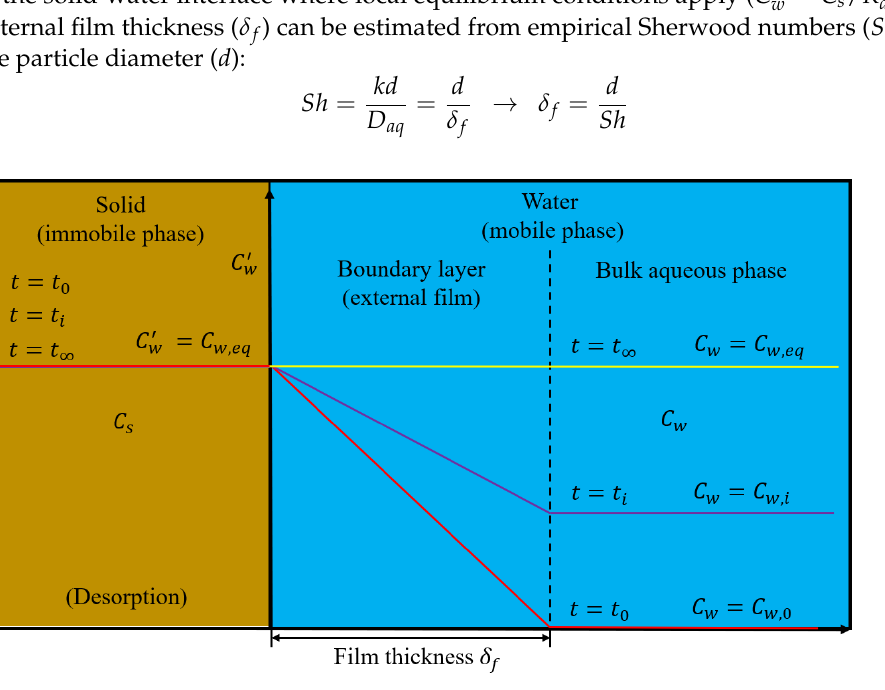
Figure 2. Scheme of mass transfer limited by film diffusion during the first flooding with fixed concentration at the interface (because the infiltrating water is always contacting fresh material as it advances).